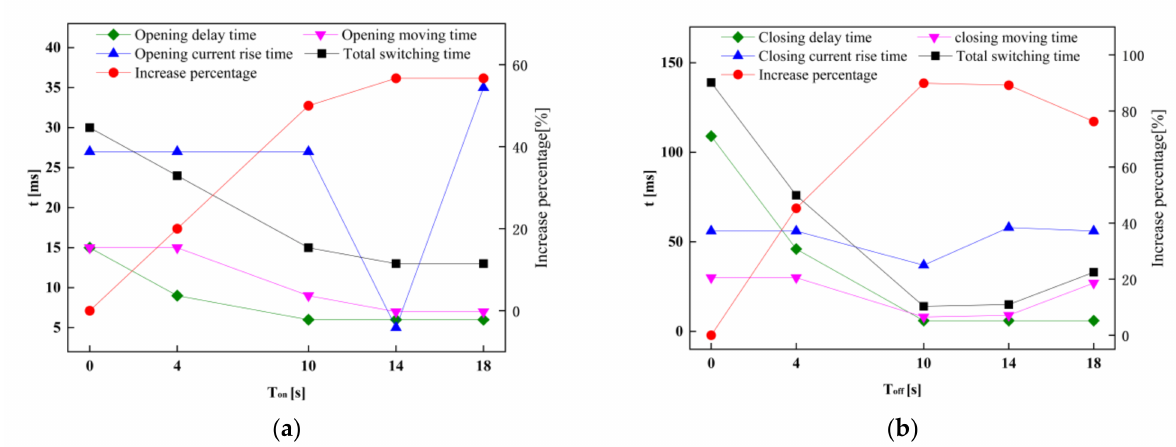
Figure 15. Simulated results of the duration of each stage of the spool by different switching times (T on ) and (T off ): ( a ) switching on; ( b ) switching off.